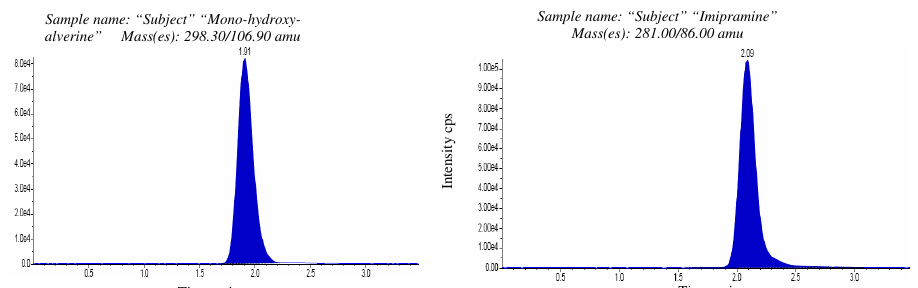
Figure 7. Representative chromatograms of subject sample for ALV spiked with IS